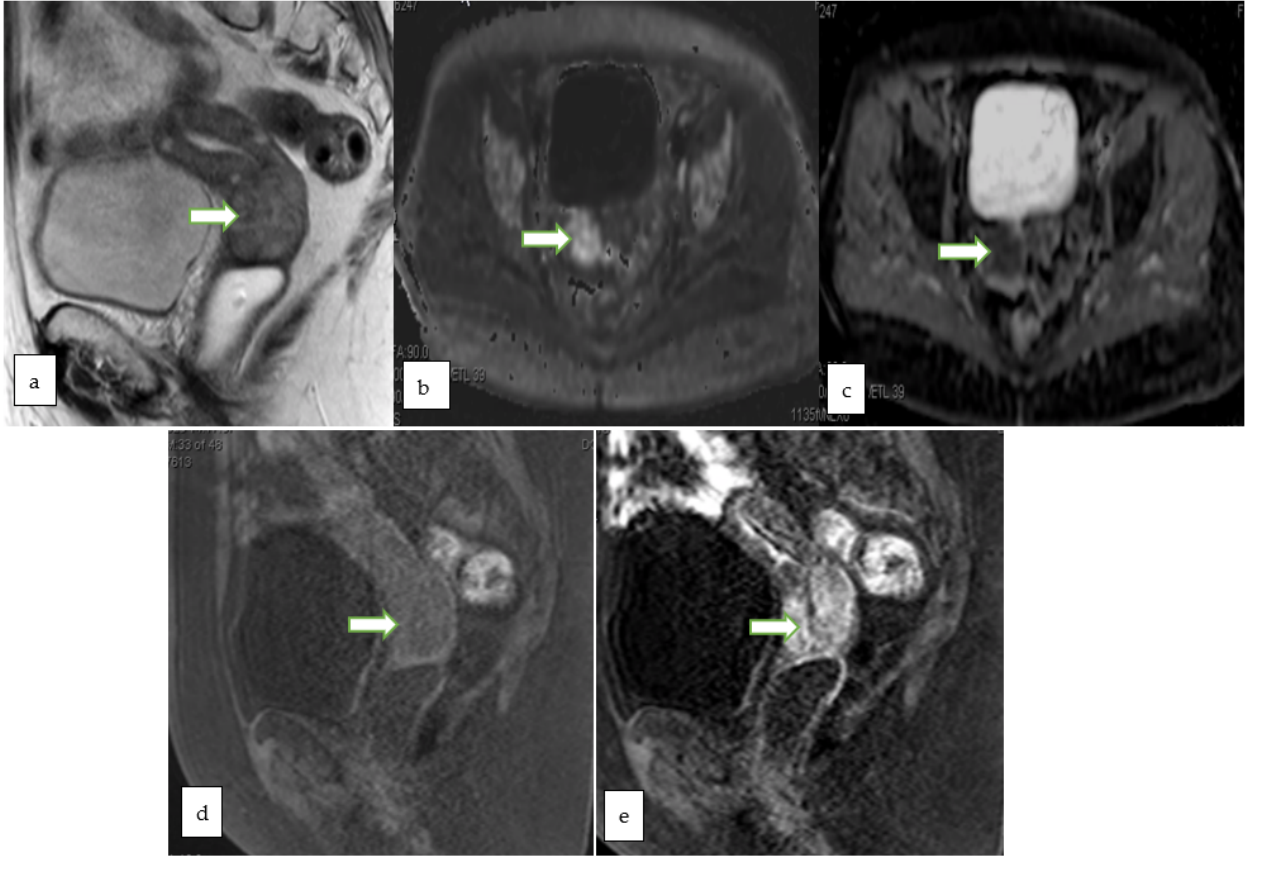
Figure 6. Sagittal T2W ( a ), Axial DWI ( b ) ADC ( c ) and sagittal T1 FS ( d ) MR images in a 78 year old lady with post-menopausal bleeding show lobulated expansile cervical mass involving the full thickness of the cervical stroma with intermediate signal on T2W images and restricted diffusion. Post contrast sagittal T1 FS image ( e ) shows early heterogeneous enhancement of the mass. A biopsy from the mass revealed detached fragments of squamous cell carcinoma.